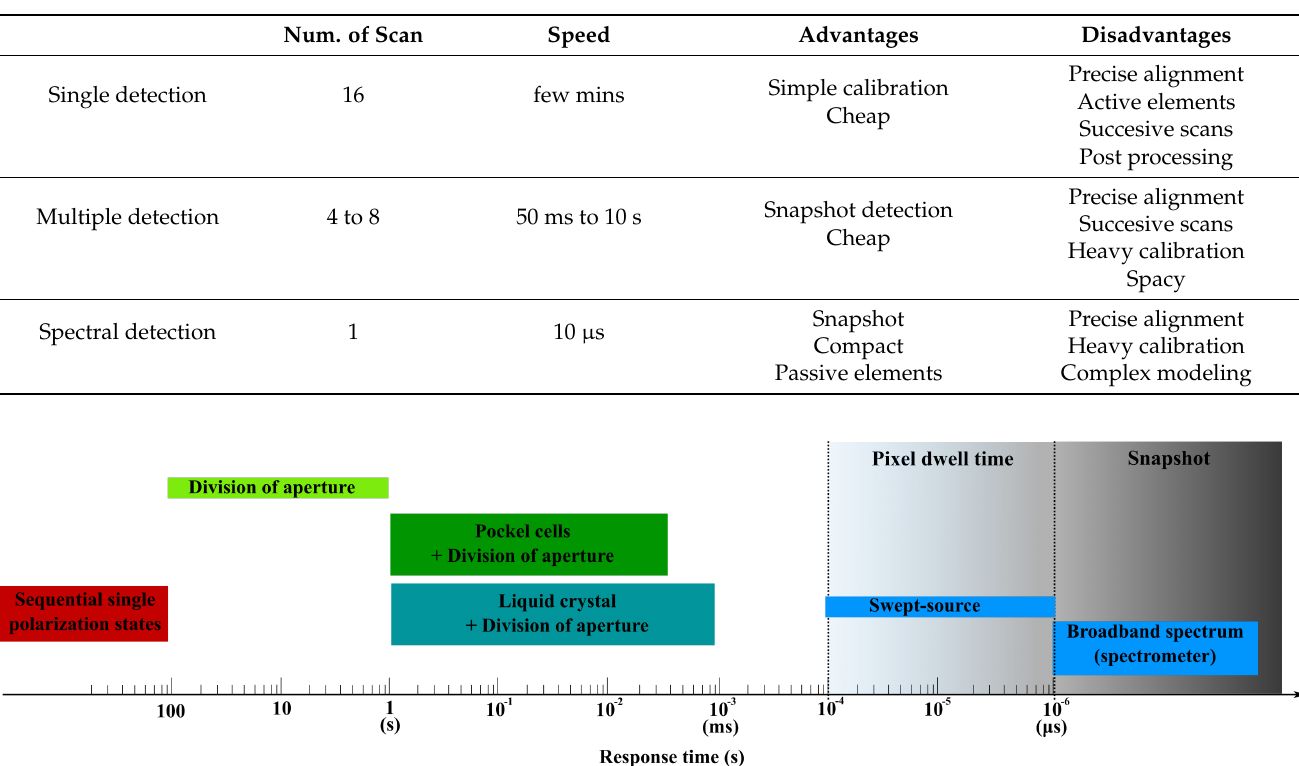
Table 1. Main performances and capabilities of the single and multiple channel temporal MM acquisition (two first lines) comparing to the spectral detection for recovering the full Mueller matrix image. The number of scan reported in the first column referred to the minimal number for retrieving the the 16 elements of the MM image. The speed referred to the lowest one for the method reported in the literature.